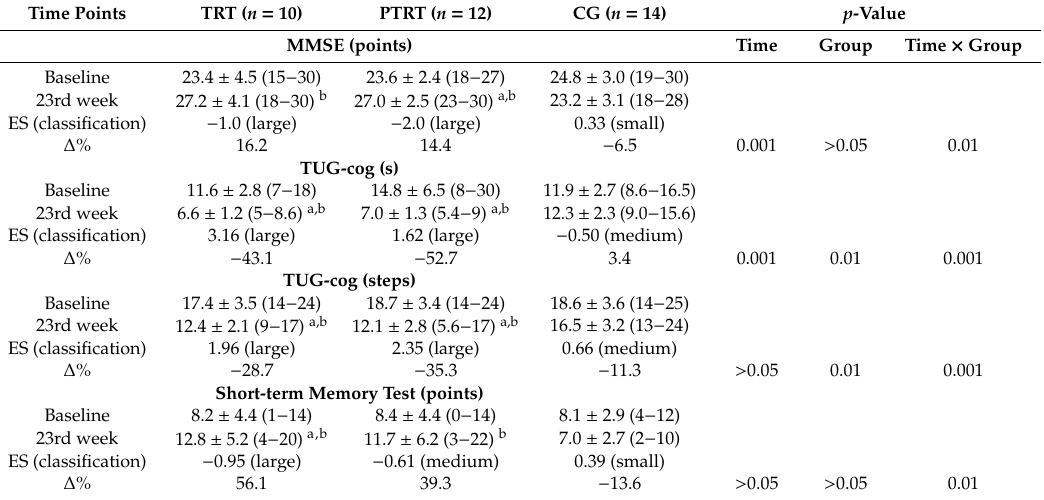
Table 2. Cognitive function at baseline and after 5, 14 and 23 weeks according to group allocation. Time